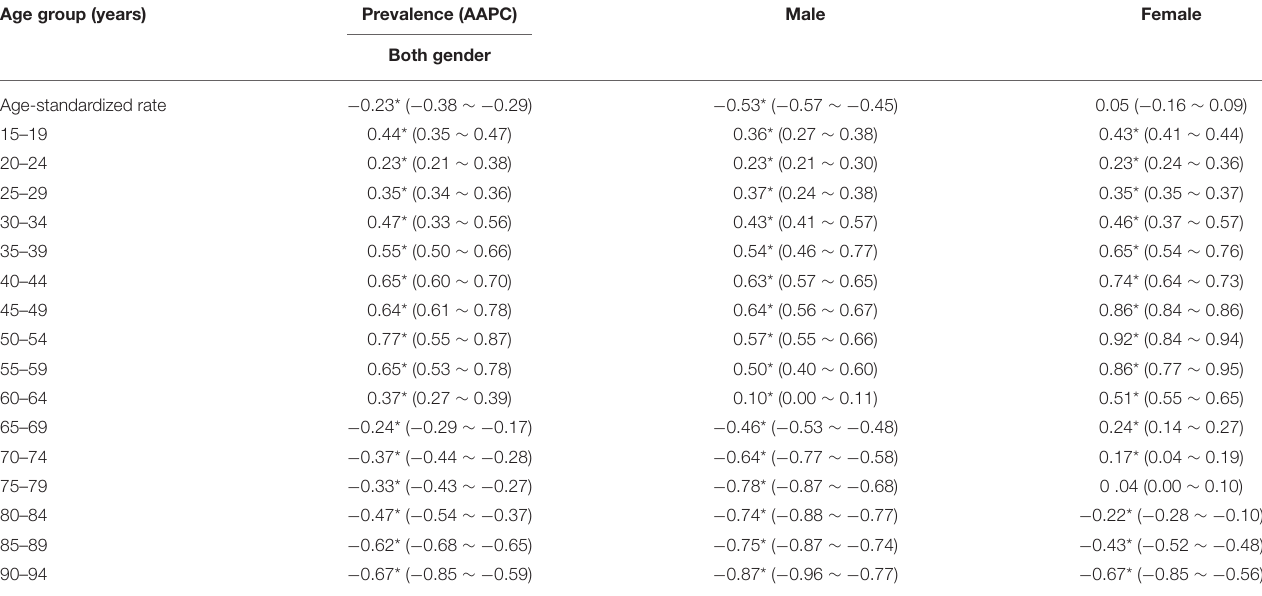
TABLE 1 | The average annual percent changes (AAPCs) in age-specifific prevalence rate of hypertensive heart disease in China, 1990–2019. Age group (years) Prevalence (AAPC) Both